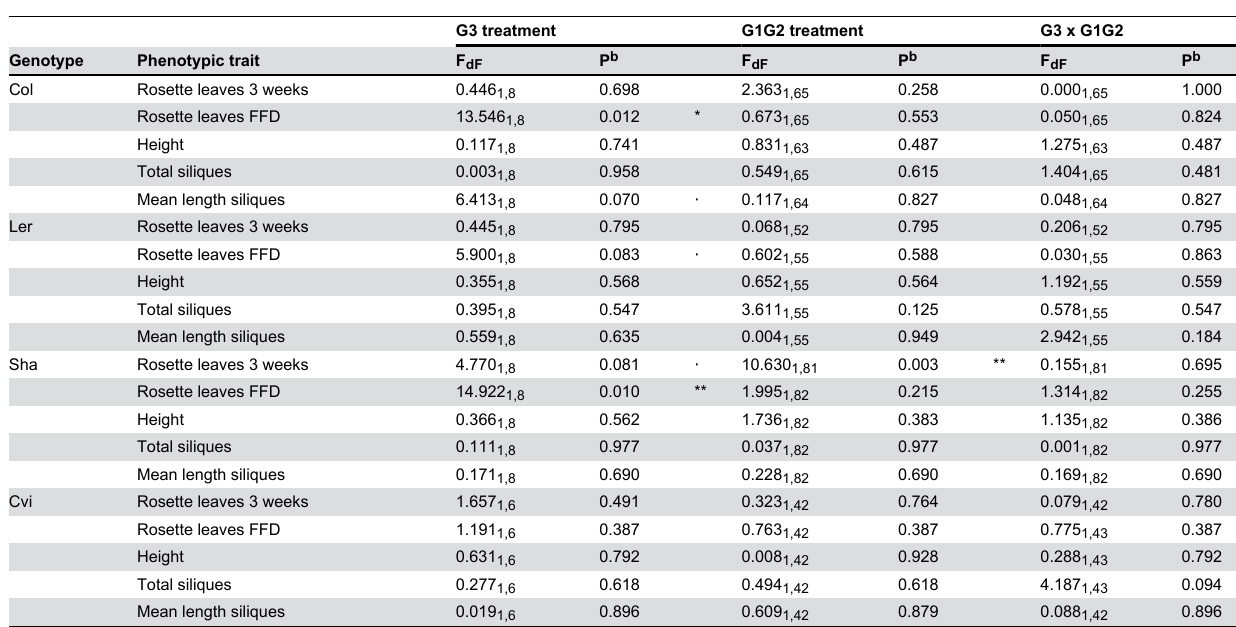
Table 2. Effects of G3 and G1G2 heat treatments including interactions on phenotypic traits separately analyzed for each genotype using linear mixed models with trays as random